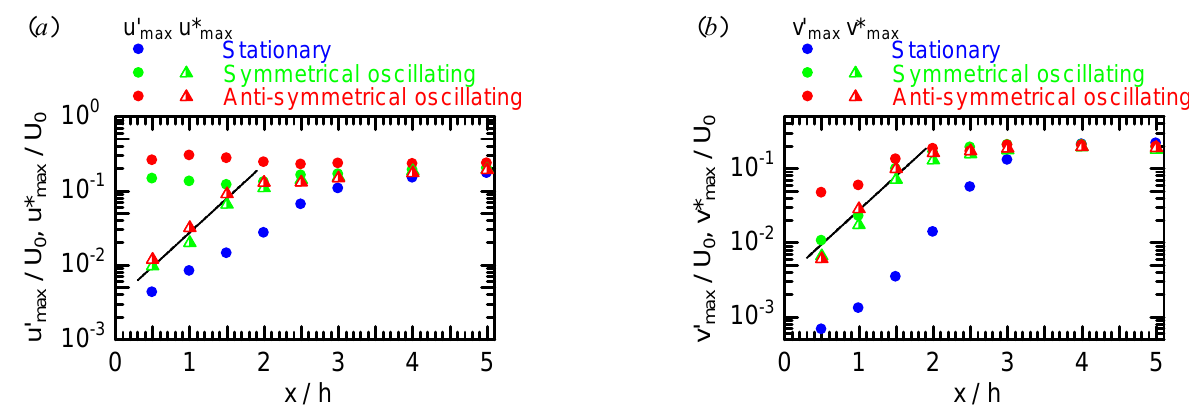
Fig. 10 Growth rate of fluctuating velocities in ( a ) streamwise and ( b ) normal